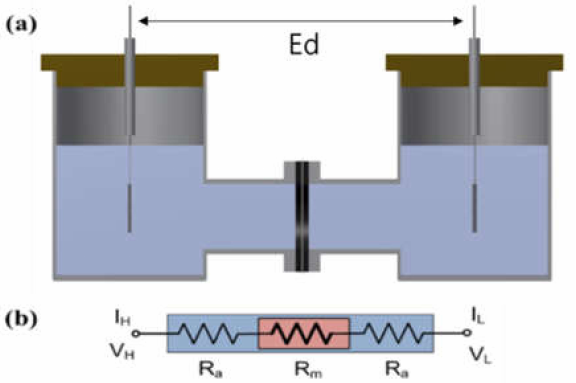
Figure 1. ( a ) H-type cell and ( b ) electric circuit: membrane immersed in a KOH condition. (V H : voltage high; V L : voltage low; I H : current high; IL: current low; R a : ohmic resistance of an alkaline solution; R m : ohmic resistance of a membrane coupon; Ed: electrode to electrode